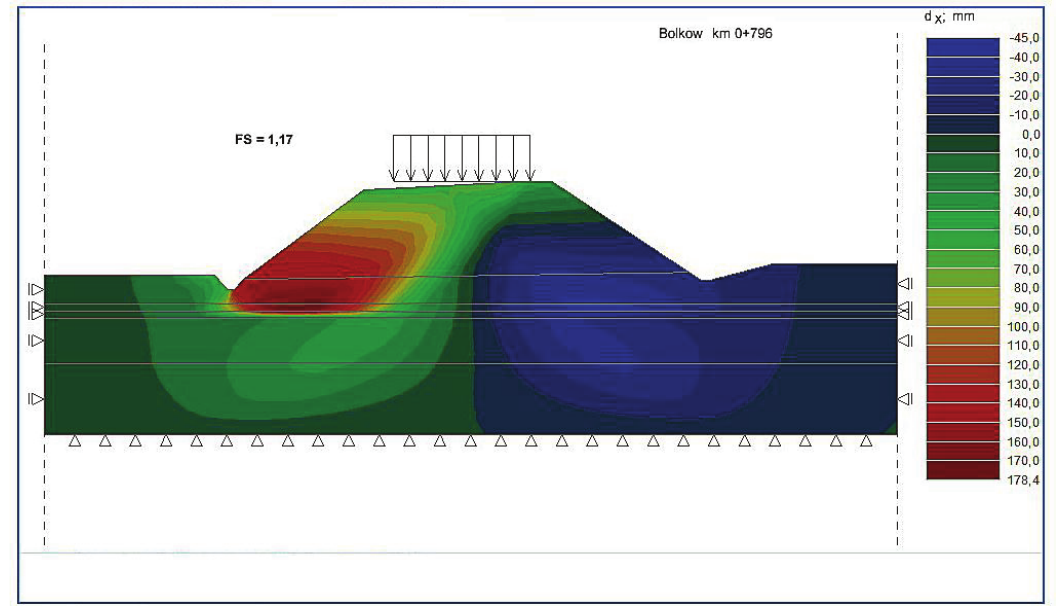
Figure 5. Cross section of km 0 + 796.18 – stability calculations (distribution of displacements) of the embankment made of cohesive soil = 20.5 kN/m 3 , ϕ = 17°, c = 22 kPa, according to Eurocode 7 ( F min = 1.17 > F req = 1.0) At km 1 + 174.22 of the ring road